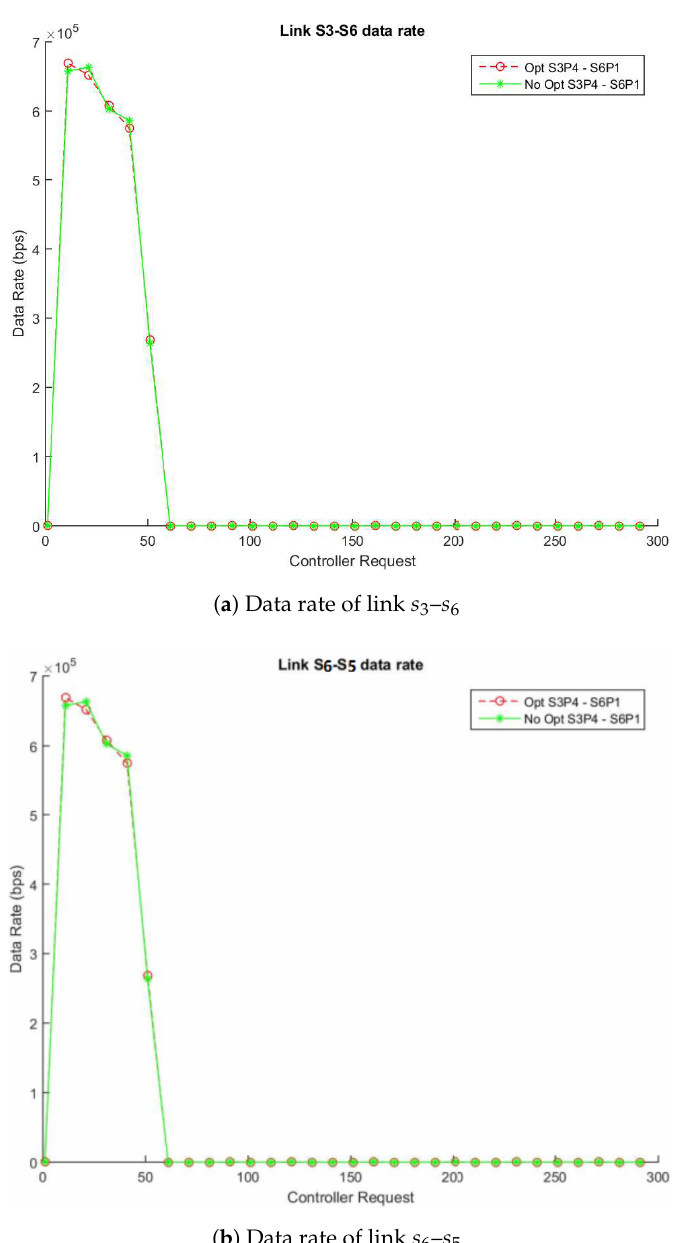
Figure 6. Enhanced vs. Non-Enhanced Data and Error Rate of